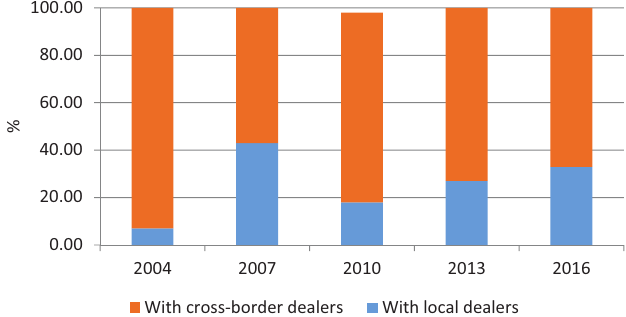
Figure 6. Total turnover by cross-border dealers and local dealers in the Lithuanian foreign exchange market in 2004–2016, in % (source: developed by the authors based on LB, 2016, 2018, 2019b; BIS, 2018b)